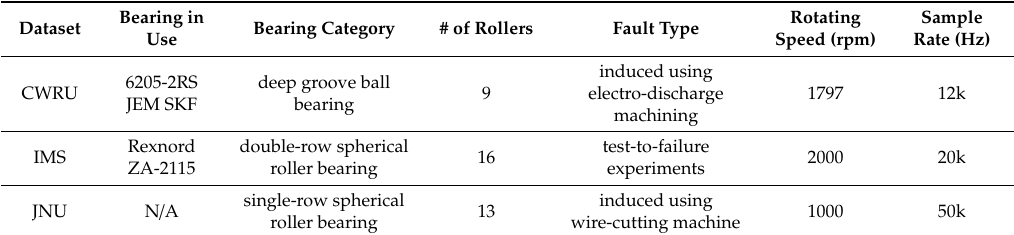
Table 2. Details of the dataset used in this experiment.